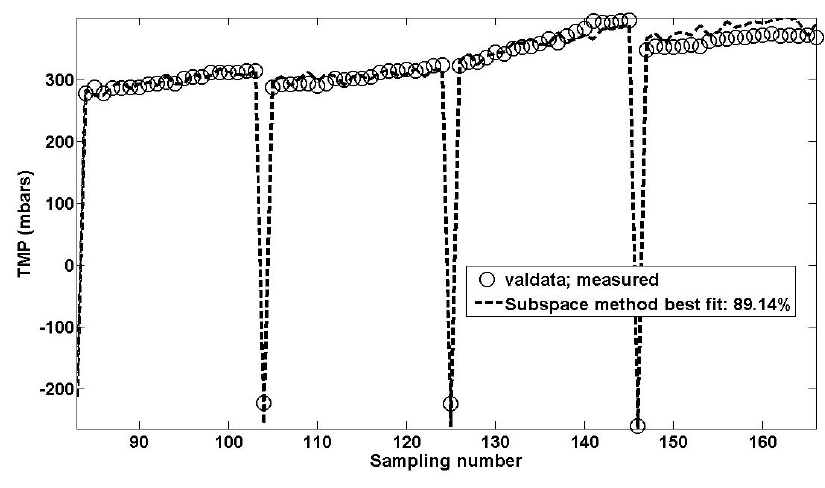
Figure 4. Best model fit for 8 flux steps (4 for validation) for sub-space